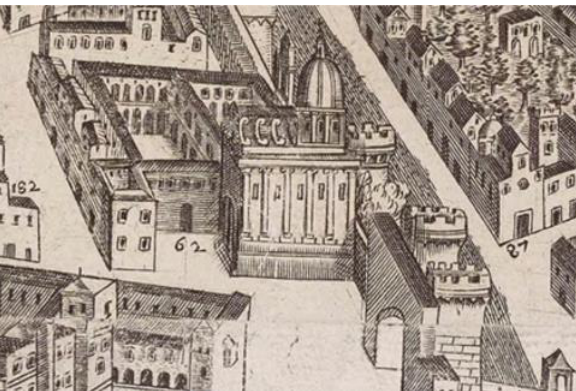
Figure 8. A. Baratta, Fidelissimae urbis Neapolitanae …, Naples 1629. Detail with the Church of Santa Caterina a Formiello, the city walls and Porta